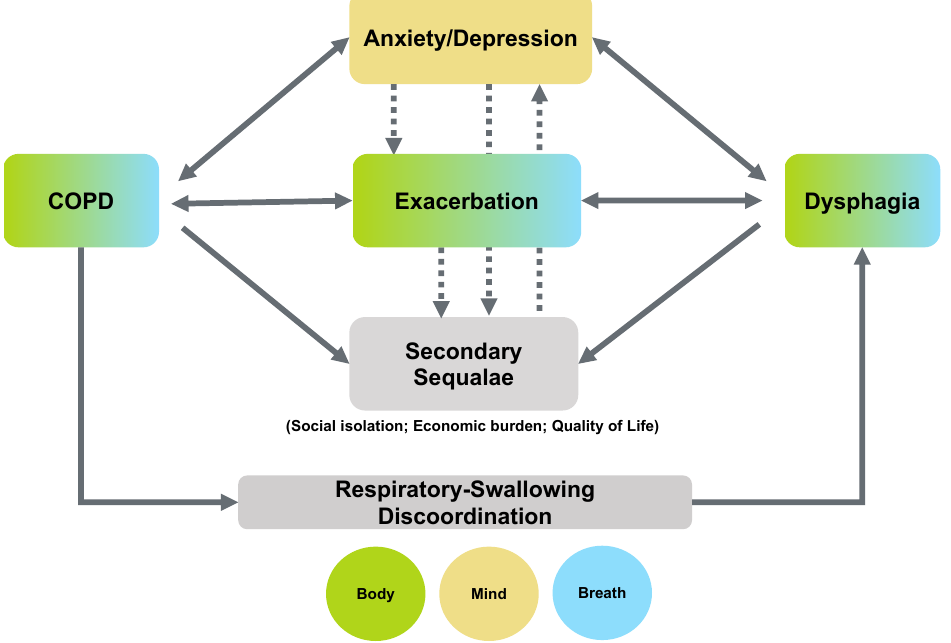
Figure 2. A model of the interplays between and across chronic obstructive pulmonary disease (COPD), dysphagia, and their related physio-psycho-emotional consequences within a mind-body-breath framework. The green boxes represent the body level, the tan boxes represent the mind level, and the blue boxes represent the breath